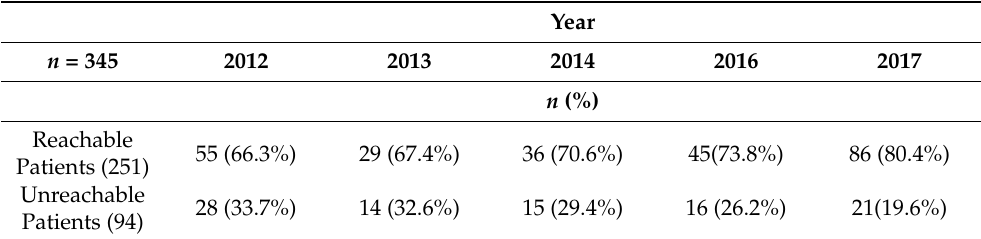
Table 2. Percentage (%) of reachable vs. unreachable patients via telephone contacts provided in patient records by year.